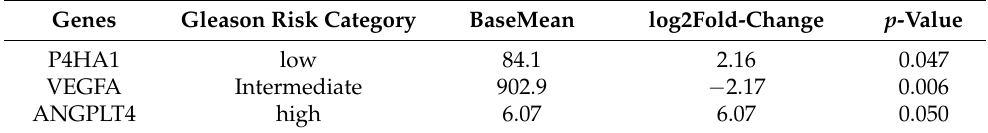
Table 2. A single significant result was obtained for each category after first grouping by Gleason score and then attempting the differential expression analysis between cancer and normal